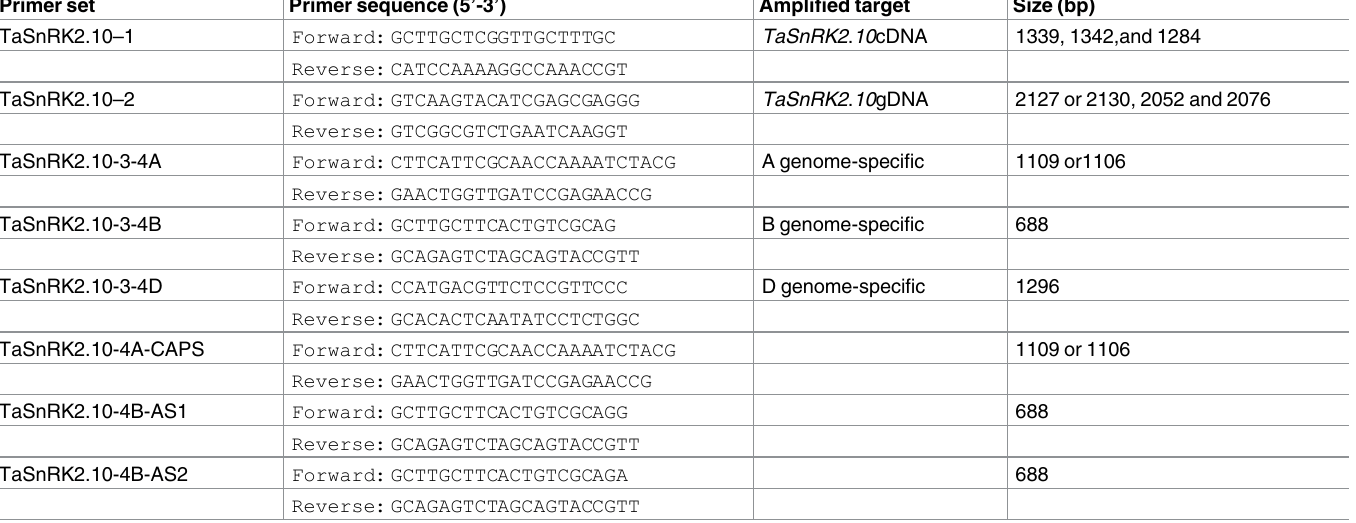
Table 1. Primers used in this study. Primer